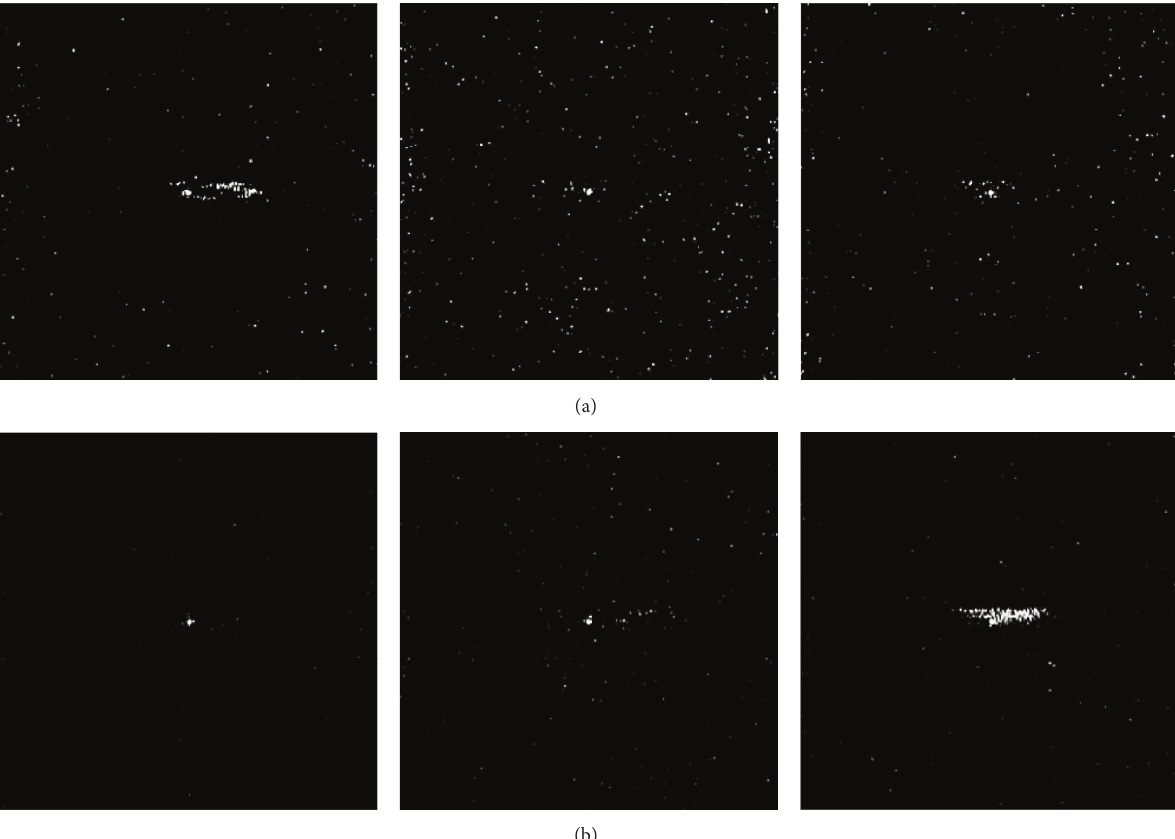
Figure 13: Typical NMRI photos of cylindrical and prismatic marble specimen in three loading direction parallel sections: (a) cylindrical specimen and (b) prismatic specimen (note: the white part of the photo means that water is detected by NMRI and this region represents damage or failure occurring inside of the specimen; impact loading direction of the specimen: from right to